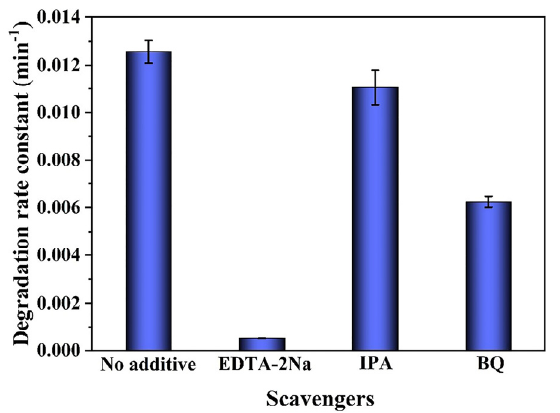
Figure 9. Trapping experiments of the active species for apparent rate constants of TC degradation over the LDH/CTF-1-40% heterojunction.